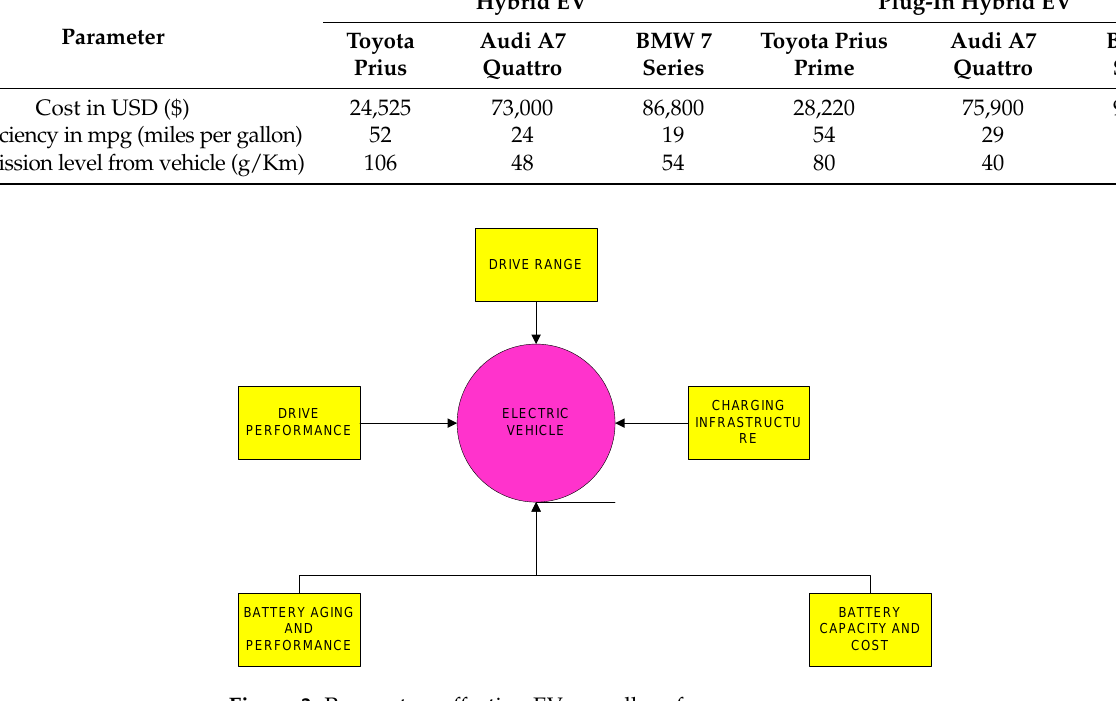
Table 2. Comparison of hybrid EVs and plug-in hybrid EVs.